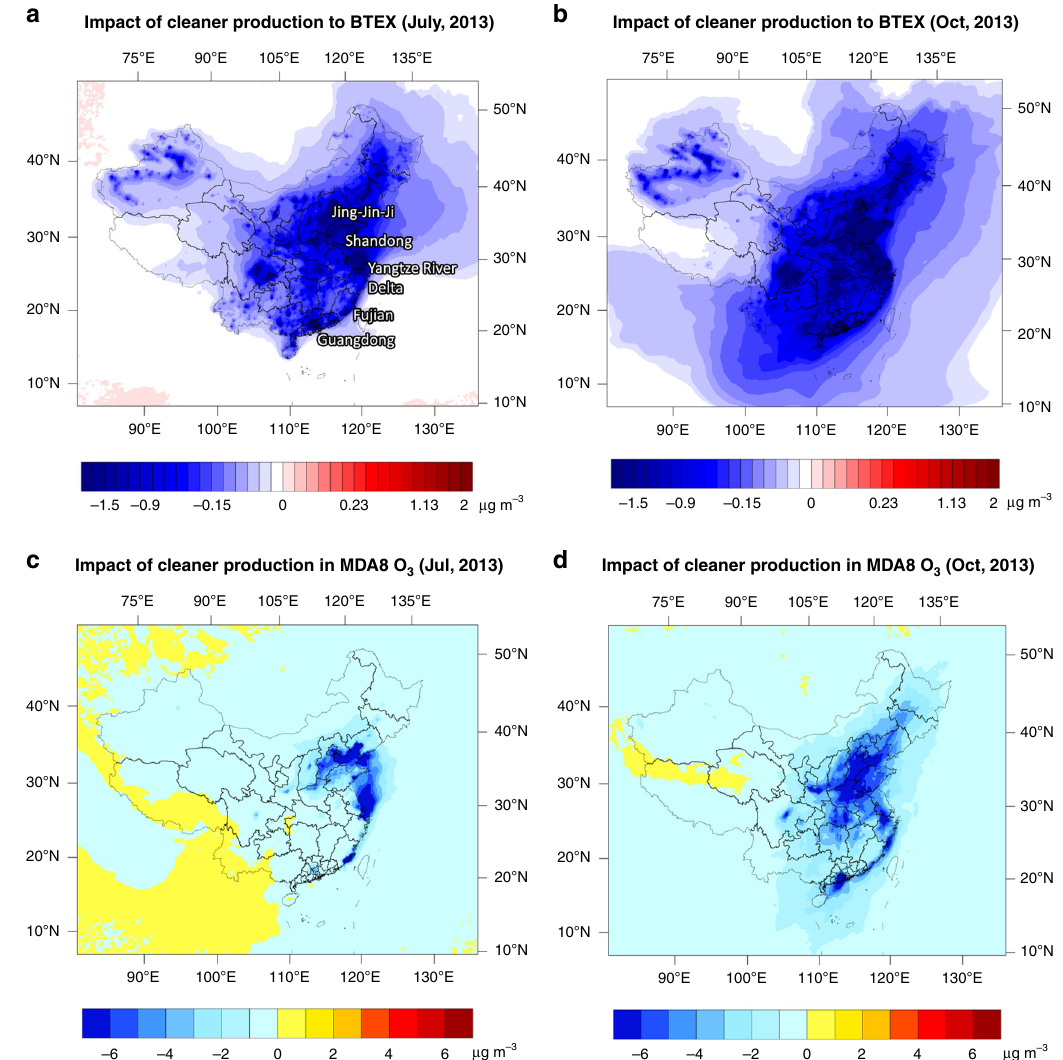
Fig. 5 Ef fi cacy of cleaner production manners in whole production capacities. a , b BTEX decreased by more than 0.5 µ g m − 3 in most areas when emission intensities of NMVOCs from key industrial sectors were lowered to European references under the 2013 emission rates. Coastal areas and the North China Plain experienced a decrease of 20 – 35% (>1 µ g m − 3 ). c , d Cleaner production manners also resulted in a nationwide decrease in MDA8 O 3 under the 2013 emission rates, especially for the east and south coast and the North China plain (2 – 8 µ g m − 3 in O 3 seasons). Source data are provided as a Source Data fi